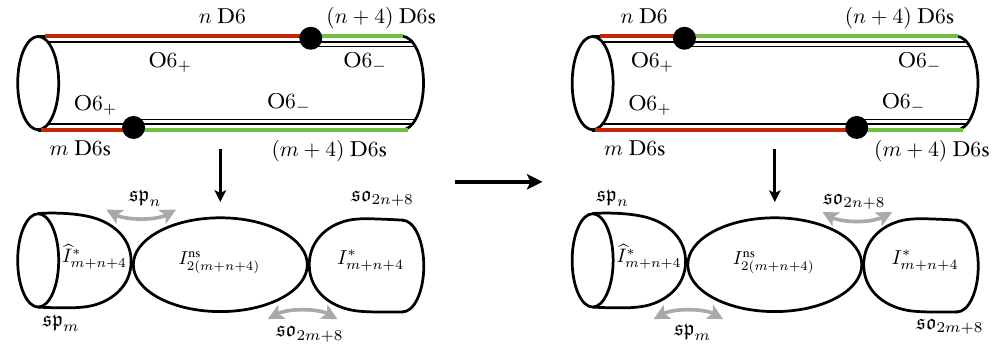
Figure 8 . A con(cid:12)guration that produces a curve touching both an I algebras sp and so 2 m +8 are shared between the (cid:12)rst two and the second two curves n